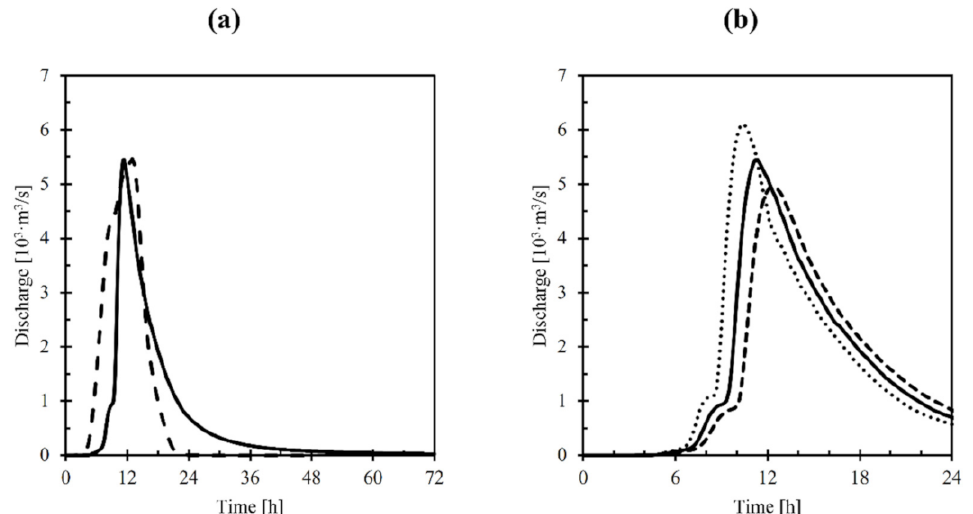
Figure 3. Results of Case Study 2: ( a ) hydrograph resulting from the aggregated approach (dashed line), and from the distributed approach, the best fit of the roughness coefficient resulted (con- tinuous line); ( b ) first 24 h of the hydrograph from the distributed approach and hydrographs considering ± 20% of the roughness coefficients (dot and dashed